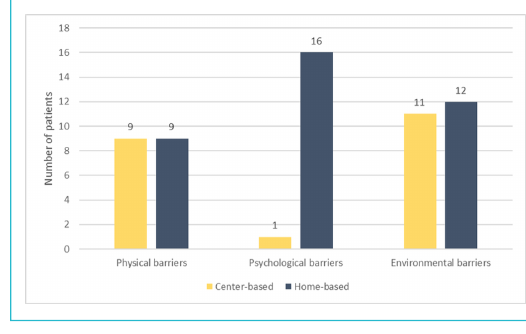
Figure 2: Comparison of barriers to centre- vs. home-based exer- cise training.